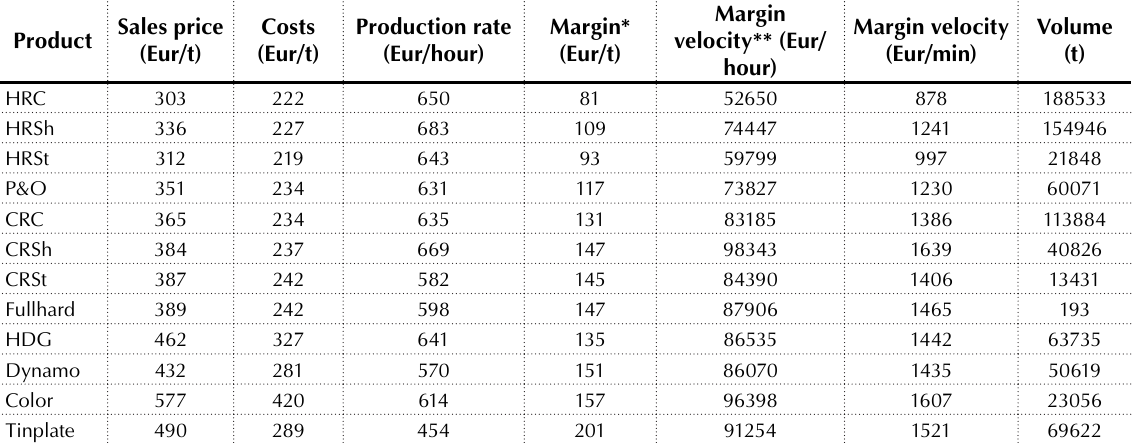
Source: Own processing.